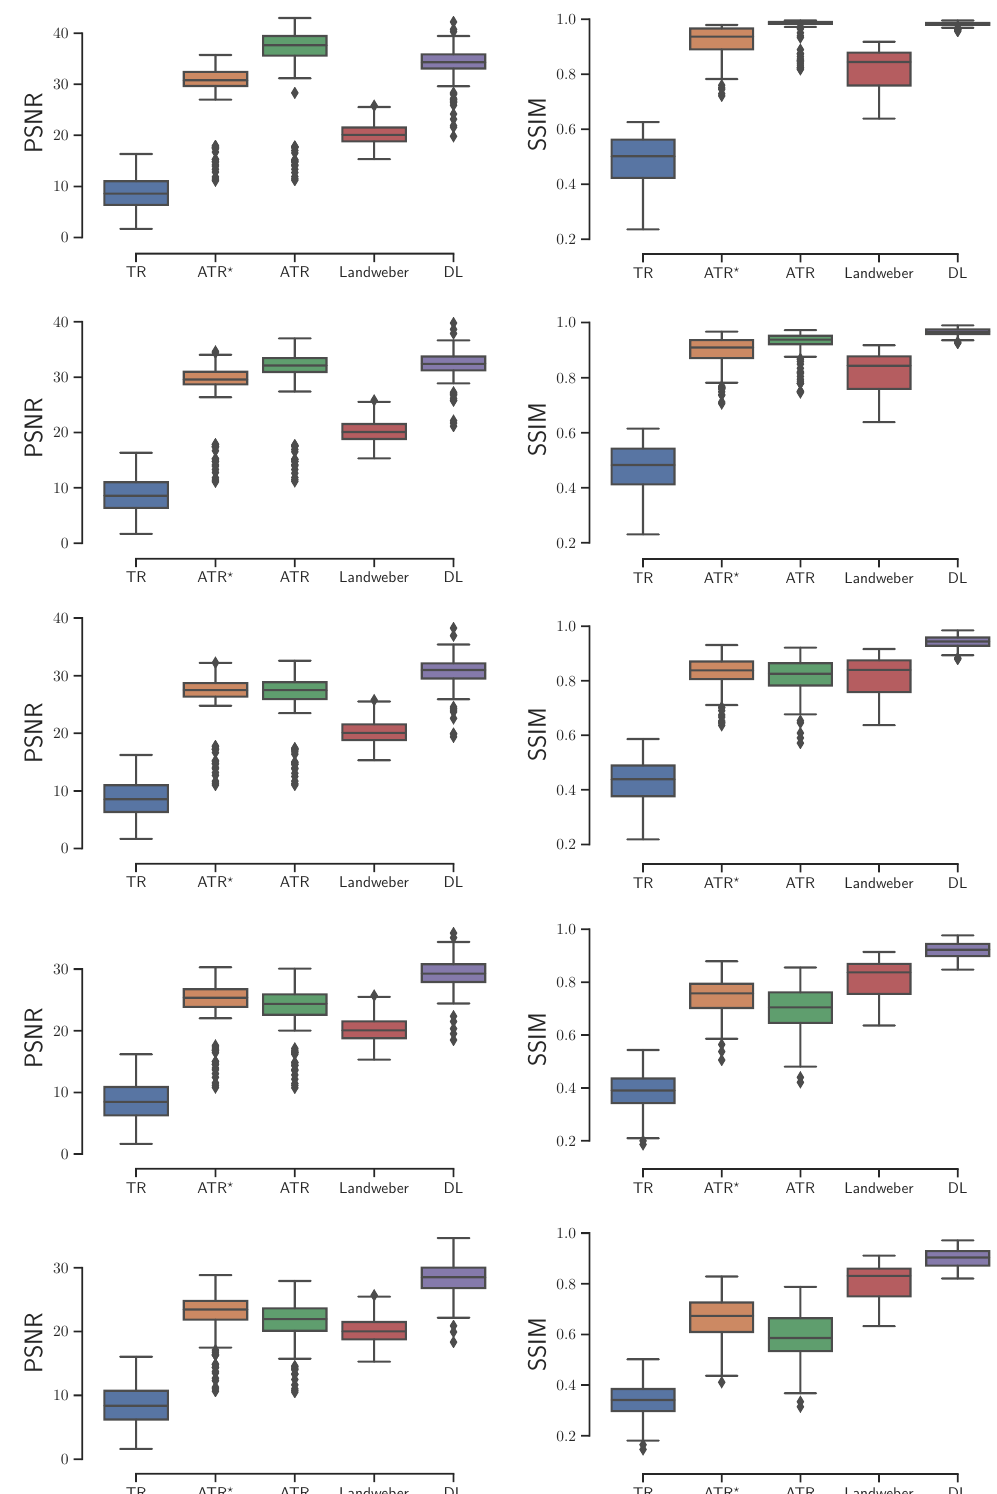
Figure 6. The box plots of the image quality evaluated by PSNR and SSIM on the testing set in a heterogeneous medium. From top row to bottom row: noise increases from 0 to 0.4. Diamonds ( (cid:5) ) indicate